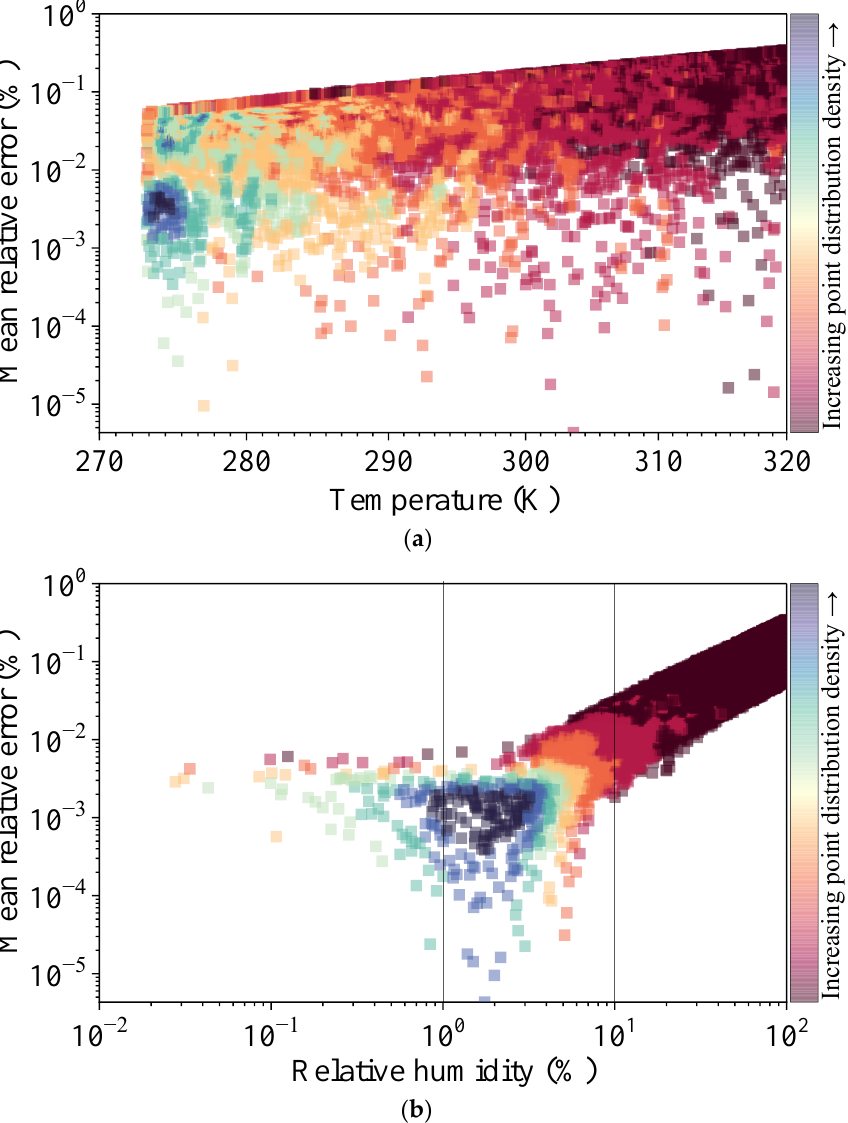
Figure 5. Distribution density and deviation versus temperature ( a ) and relative humidity ( b ).